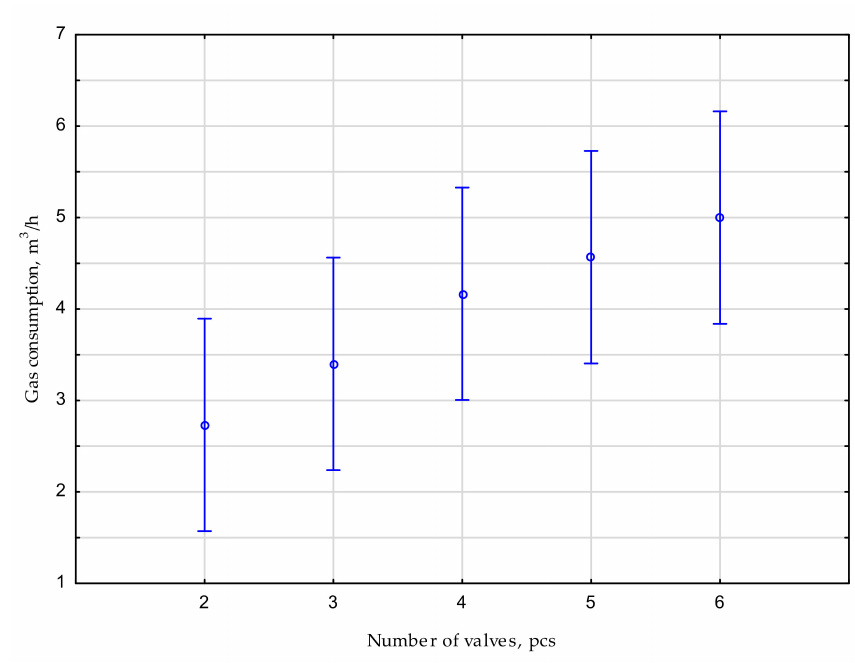
Figure 3. Impact of number of valves on the gas consumption.